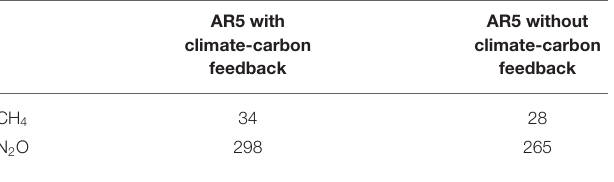
TABLE 2 | Global warming potential over 100-years horizon for CH 4 and N 2